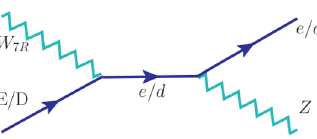
Figure 6 . A typical Feynman diagram that contribute to co-annihilation of DM. There is an additional diagram with exotic charged lepton E replaced by E c 0 and SM charged lepton replaced by